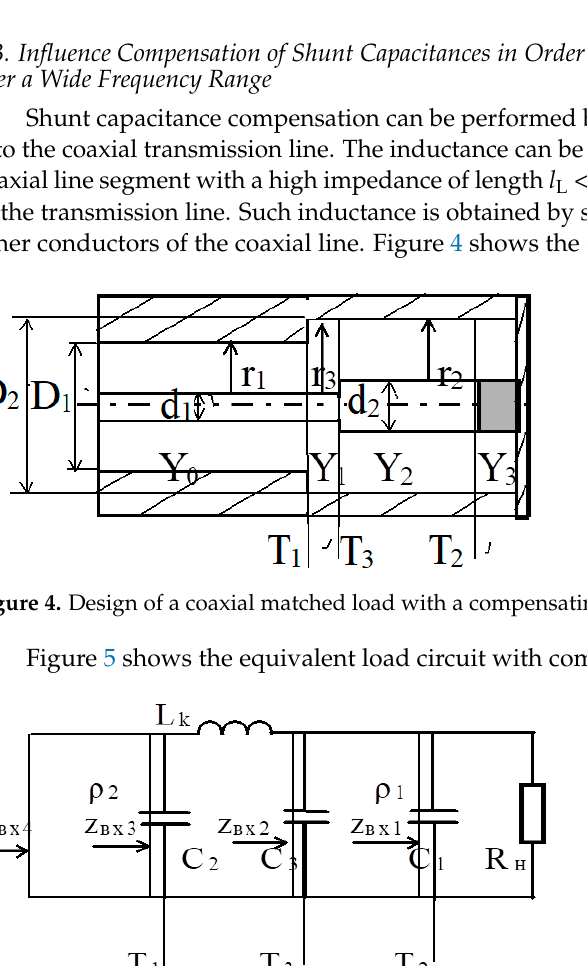
Figure 6. Scheme of coaxial matched load. 1. Lid. 2. Washer. 3. Insulator (PTFE F-4, ε = 2). 4. Body. 5. Rubber ring. 6. Metal ring. 7. Nut. 8. Resistor C-6-9 (50 Ohm; 125 mW). 9. Rod. A standard small-sized coaxial 50-ohm connector [31] with a cross-section of 4.15 × 1.3 mm with PTFE filling was used to connect to external devices. A coaxial line with the same cross-section serves as a continuation of the connector, which makes it possible to ensure high-quality matching at the interface due to the regularity of the electromagnetic field structure. To ensure fixation of the central conductor of the coaxial line, its